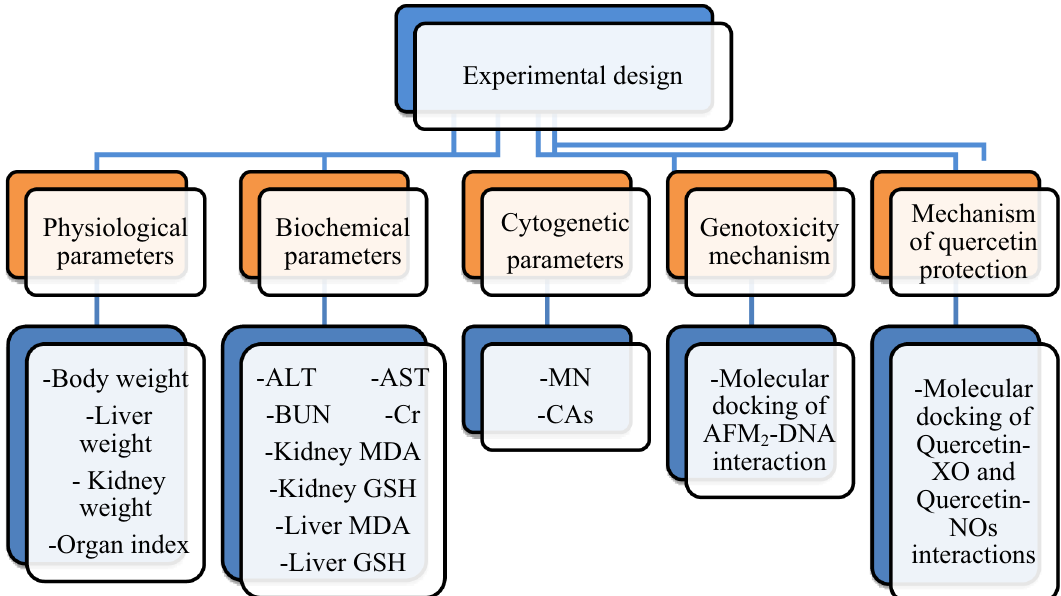
Figure 1. Experimental design. MDA: malondialdehyde, GSH Glutathione, ALT Alanine aminotransferase, AST Aspartate aminotransferase, BUN Blood urea nitrogen, Cr Creatinine, MN Micronucleus, CAs Chromosomal abnormalities, XO Xanthine oxidase, NOs Nitric oxide